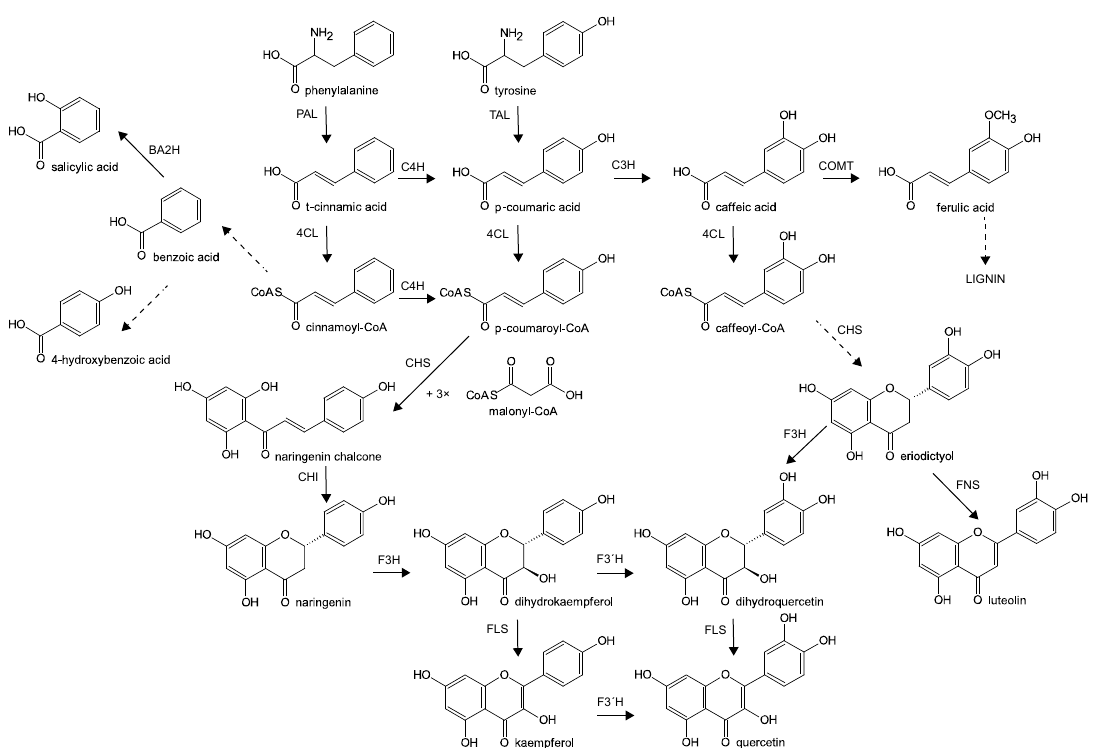
Figure 2. Pathways of phenolic acid and flavonoid metabolism [19–22]. PAL—phenylalanine Figure 2. Pathwaysofphenolicacidandflavonoidmetabolism[19–22].